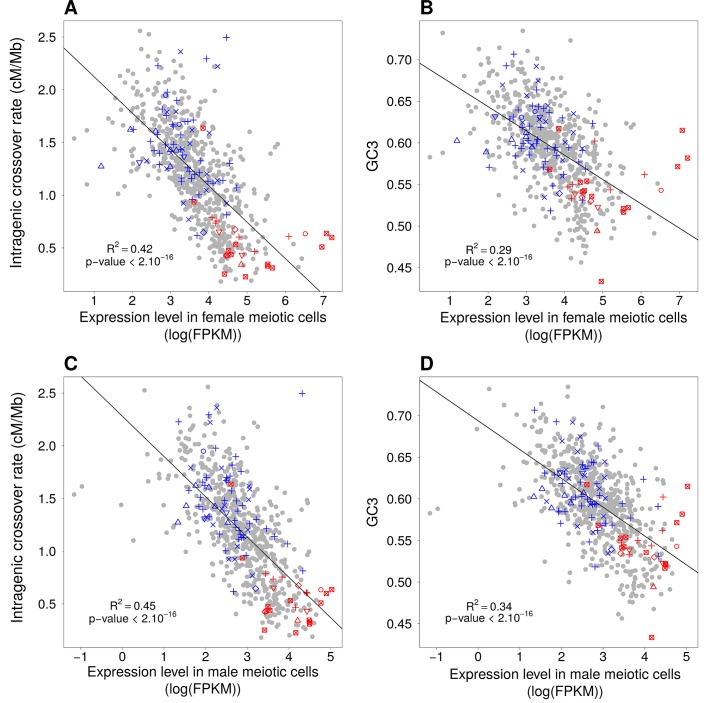
Relationships between expression levels in female or male meiotic cells and GC3 and intragenic crossover rates.(A, B) Same as Figure 6B and C, but with expression level measured by single-cell analysis of female primordial germ cells at 17 weeks (Guo et al., 2015). (C, D) Same as 6B and C, but with expression level measured in male meiotic cells (Lesch et al., 2016). Expression levels are expressed in log(FPKM).